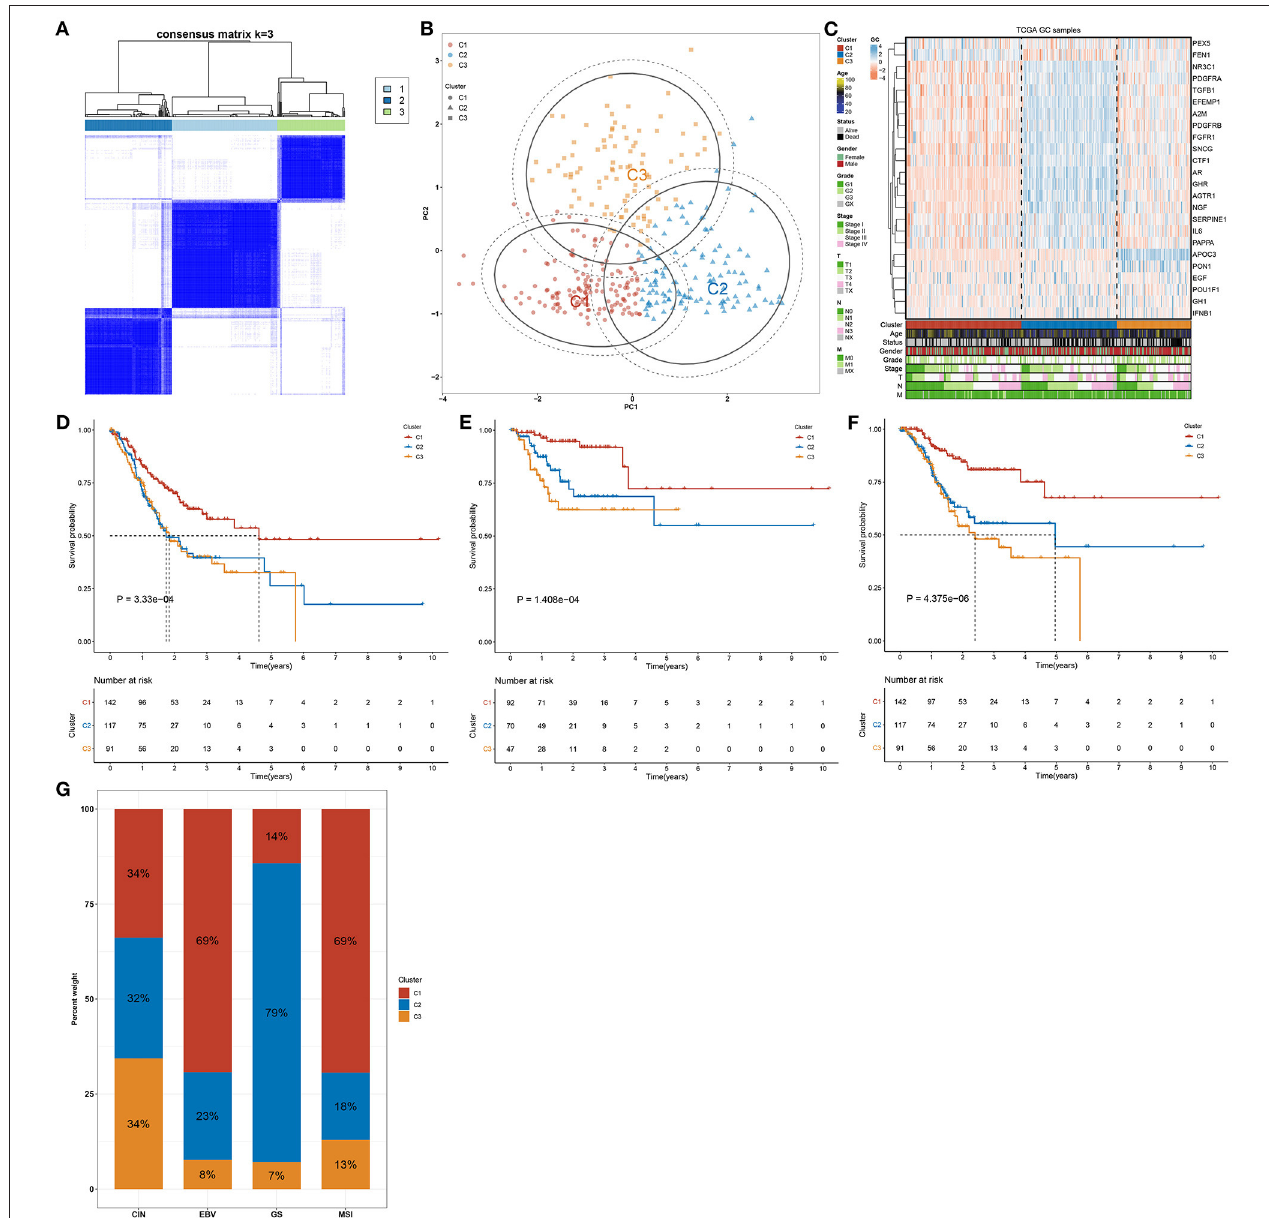
FIGURE 1 | Aging-genomic profiles identify three molecular phenotypes in gastric cancer. (A) Heatmap depicted sample clustering at consensus k = 3 in accordance with the transcriptome profiling of prognostic aging-relevant genes across gastric cancer samples in the TCGA cohort. (B) PCA plots visualized the dissimilarity between aging-relevant molecular phenotypes. (C) Heatmap showed the expression patterns of prognostic aging-relevant genes in three aging-relevant molecular phenotypes. (D–F) Kaplan–Meier curves of (D) OS, (E) DFS, and (F) DSS were conducted for gastric cancer patients with diverse aging-relevant molecular phenotypes. (G) Distribution of aging-related molecular phenotypes C1, C2, and C3 in different molecular subtypes (CIN, EBV, GS, and